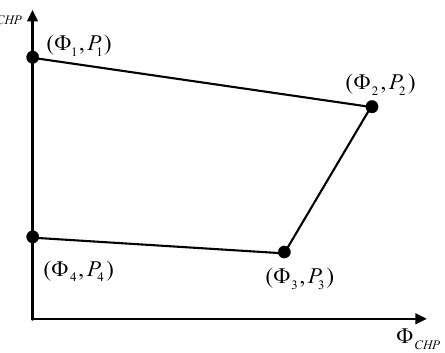
Figure 6. Electrothermal characteristic diagram of the extraction condensing unit.